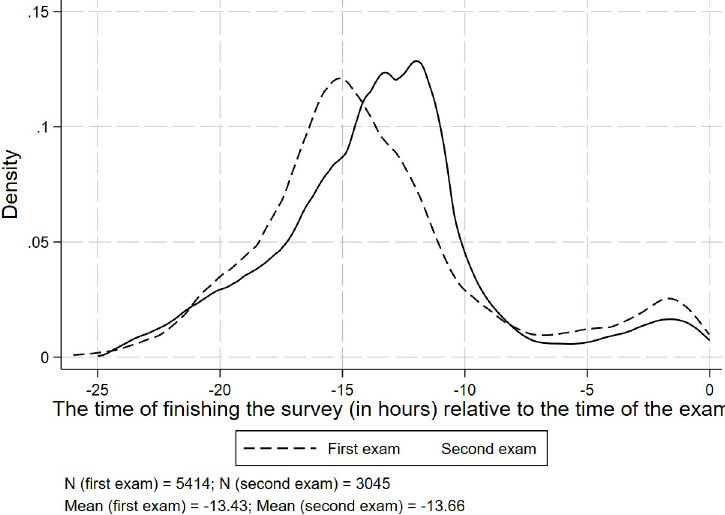
Fig 1. The relative time difference in hours between finishing the survey and the beginning of the exam.